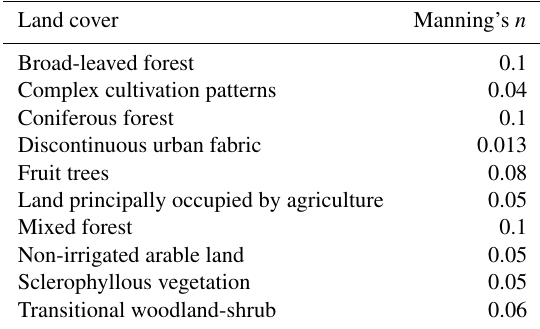
Table 2. Manning’s n roughness coefficient values used for flood modelling (adapted for CORINE land cover categories; Papaioan- nou et al.,